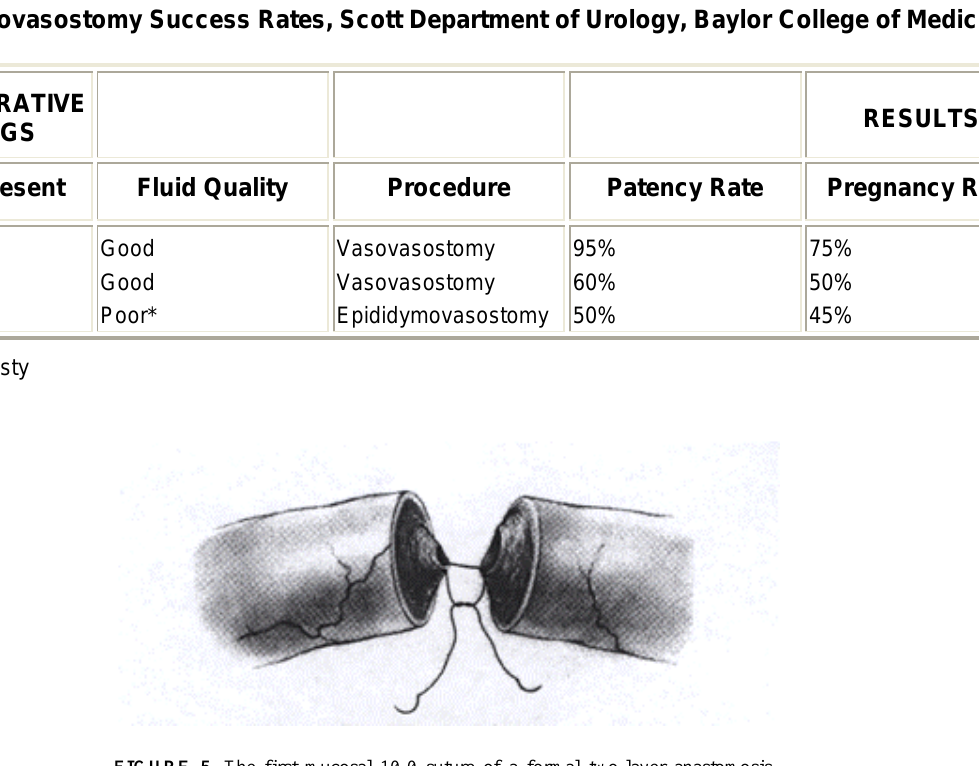
FIGURE 5. The first mucosal 10-0 suture of a formal two-layer anastomosis. (Fig. 5-8 Modified from Thomas, A.J., and Howards, S.S.: Microsurgical